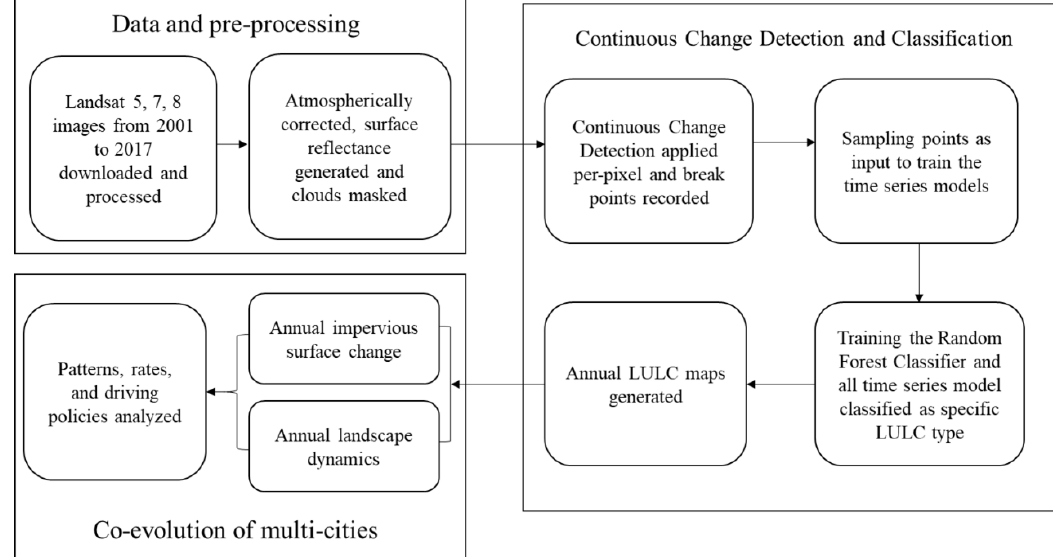
Figure 2. Methodology flowchart in this study.